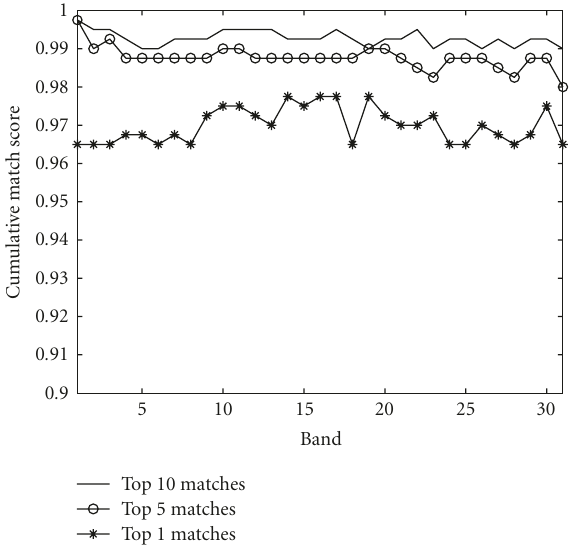
Figure 4: Cumulative match scores of spectral signature method and the best single-band eigenface